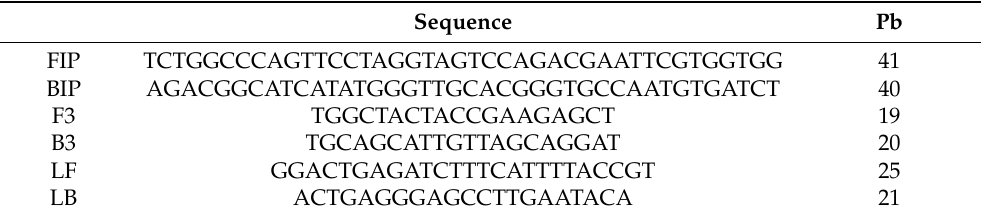
Table 1. Sequence of primers for RT-LAMP with target gene N according to references [23,30].